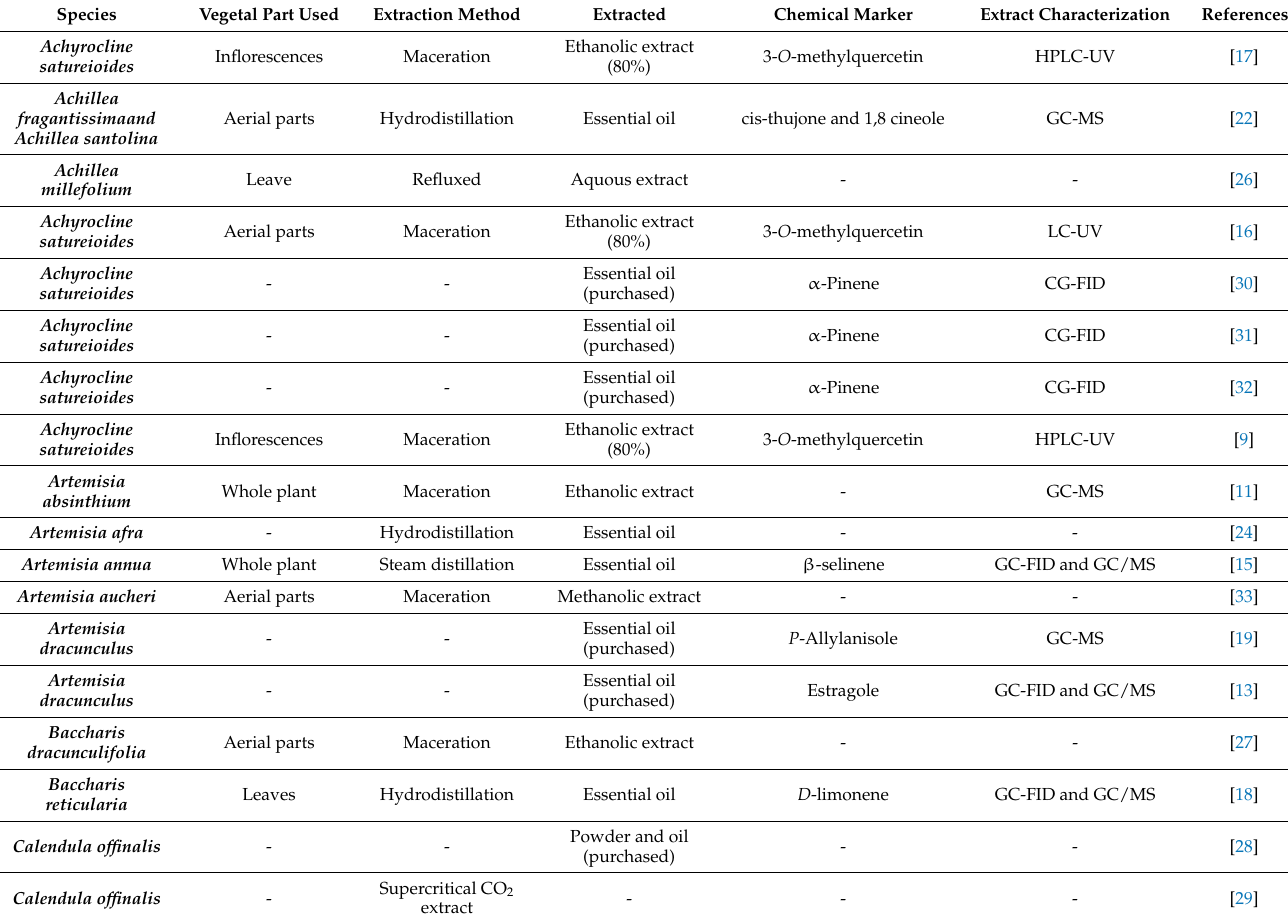
Table 2. Phytochemical characteristics of the species used in the development of the